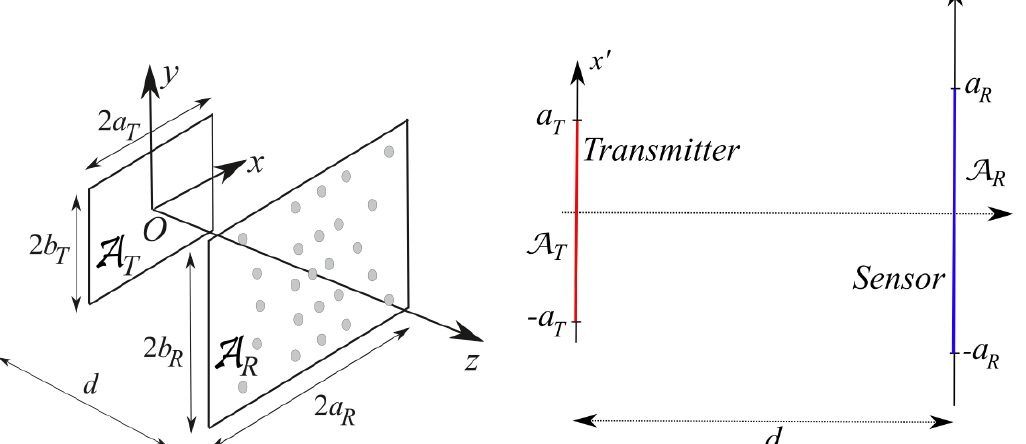
Figure 1. Left: geometry of the 3D problem. Right: geometry of the 2D